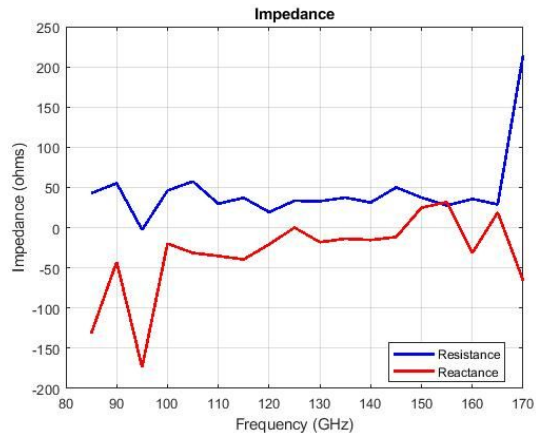
Figure 14. Impedance versus frequency.